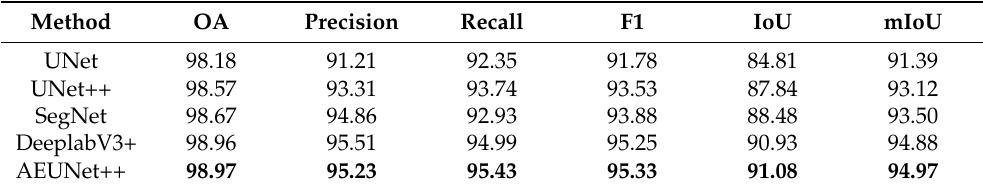
Table 2. Quantitative comparison of OA, Precision, Recall, F1, IoU and mIoU for the WHU aerial image data set.